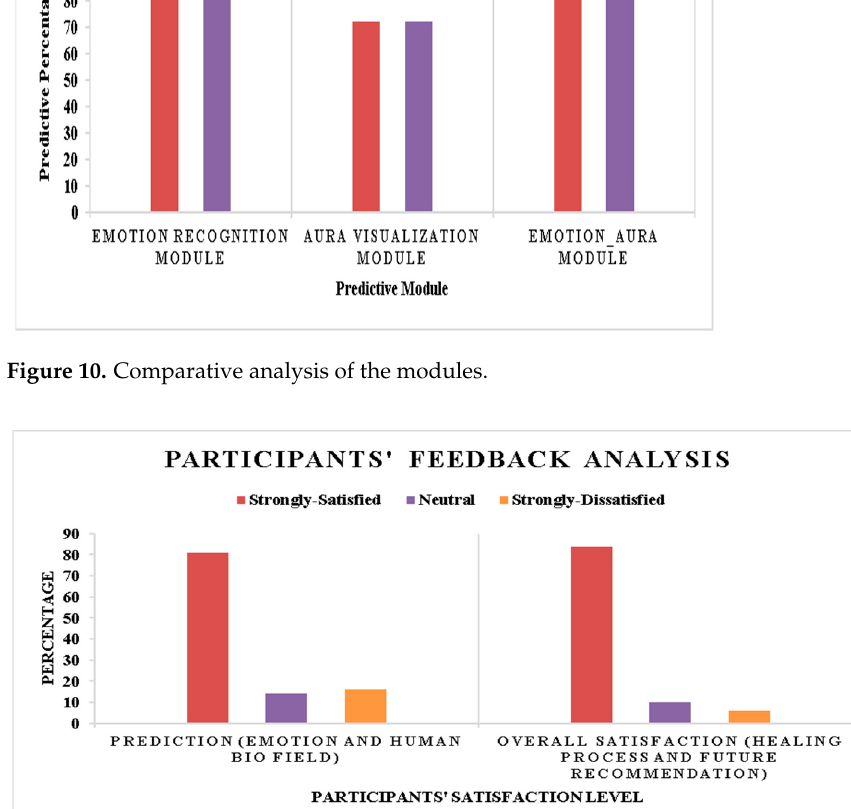
Figure 11. Participant feedback analysis based on the satisfaction level.